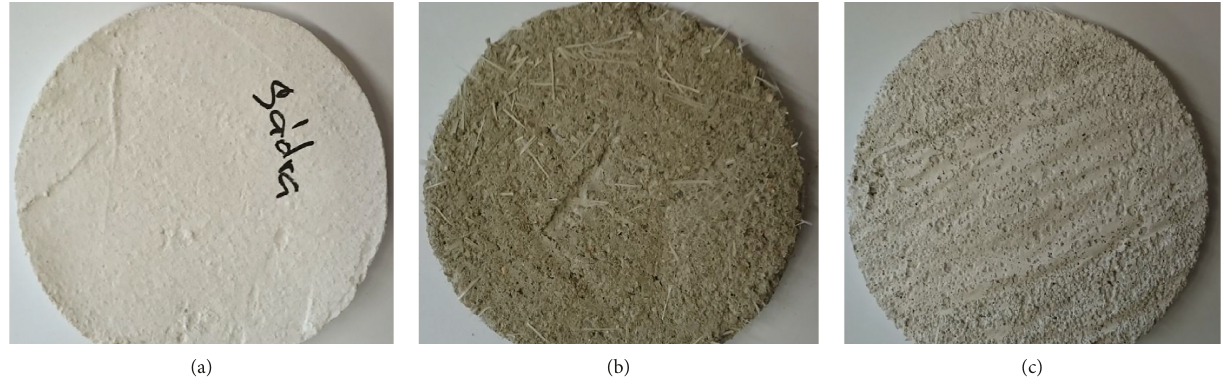
Figure 4: Tested samples: (a) gypsum, (b) cement with glass fibre, and (c) lime